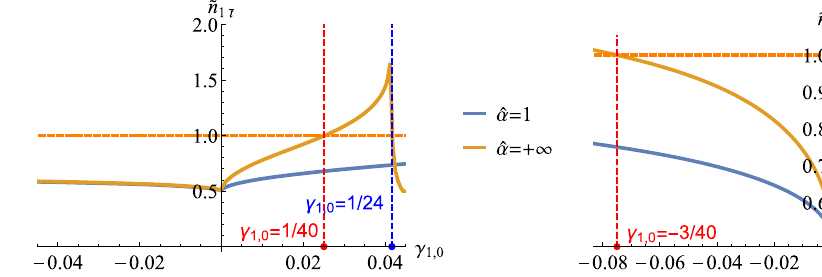
Fig. 17 ˜ n 1 ¯ t and ˜ n 1 y as a function of γ 1 , 0 for representative ˆ α